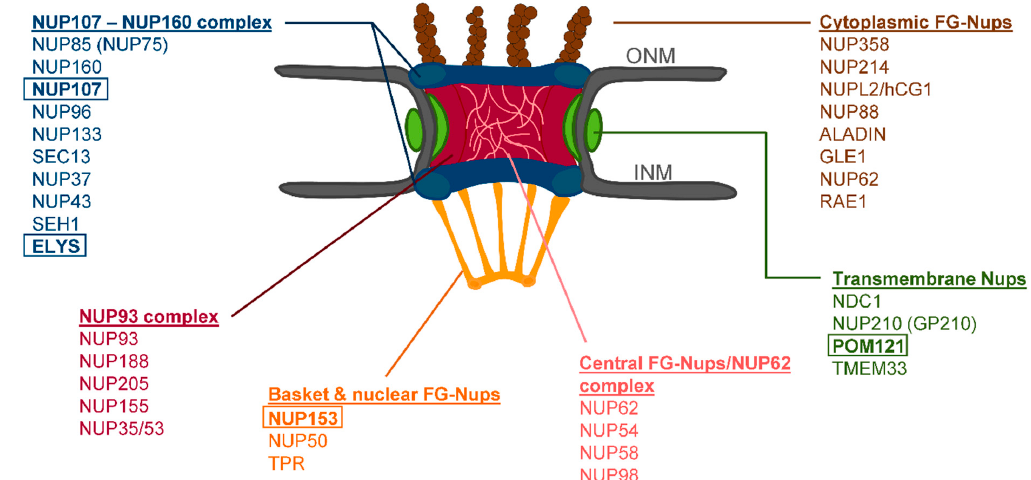
Figure 1. Schematic representation of the nuclear pore complex (NPC) architecture. The cytoplasmic and nucleoplasmic ring (NUP107-160 complex) are shown in blue, the transmembrane nucleoporins (NUPs) in green, the central ring (NUP93 complex) in red, the cytoplasmic filaments in brown, the nuclear basket in orange, and the central FG NUPs in pink. Boxes indicate NUPs analyzed in this